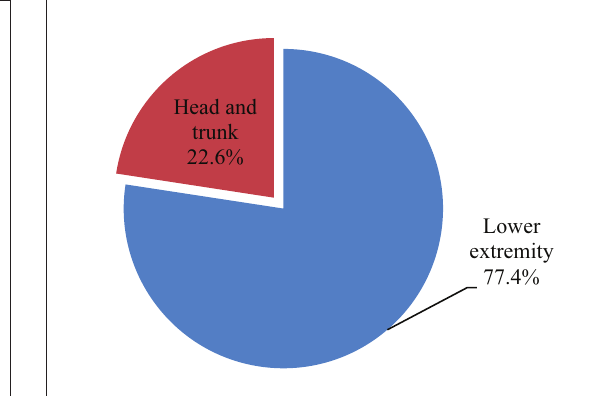
Figure 3. Throwers’ injured body parts Figure 4. Sprinters injured body parts